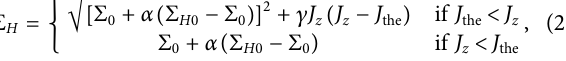
withdifferent λ R ,where λ R isthemagneticlatitudeof R m (cid:1) 0at23MLT.Panels (A) and (B) showthedistributions m (cid:1) 0 m (cid:1) 0 PS λ (cid:1) 60 ° and 54 ° , respectively. m PS with R m (cid:1) 0